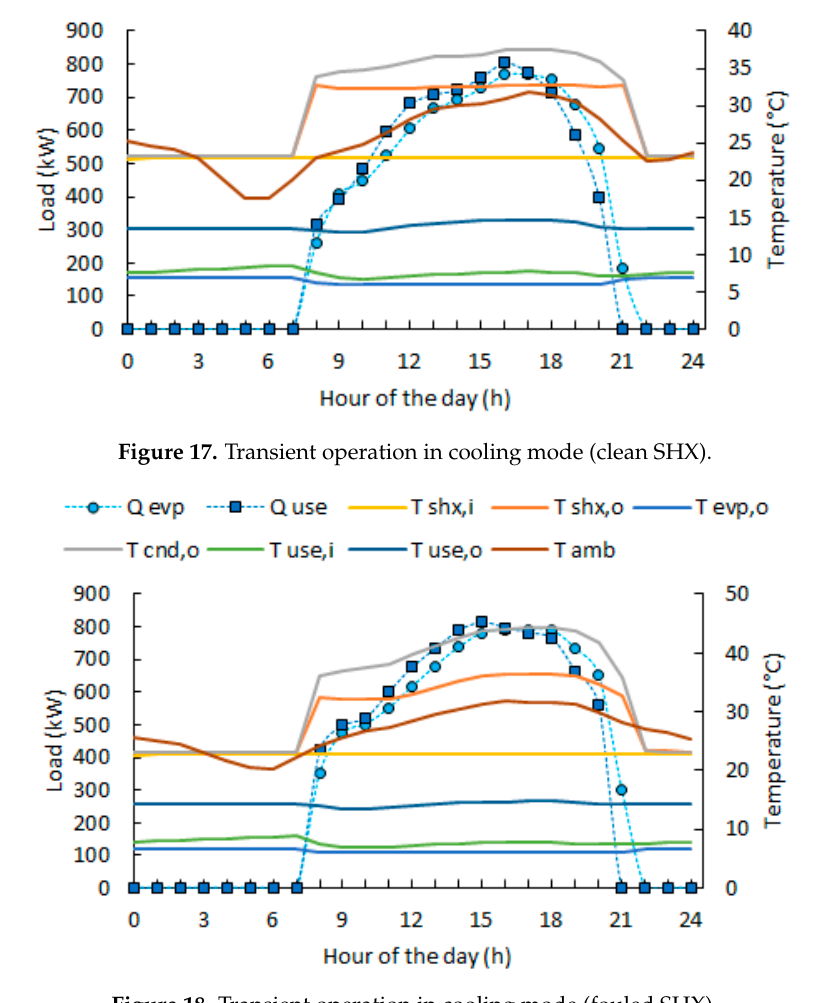
Figure 18. Transient operation in cooling mode (fouled SHX).